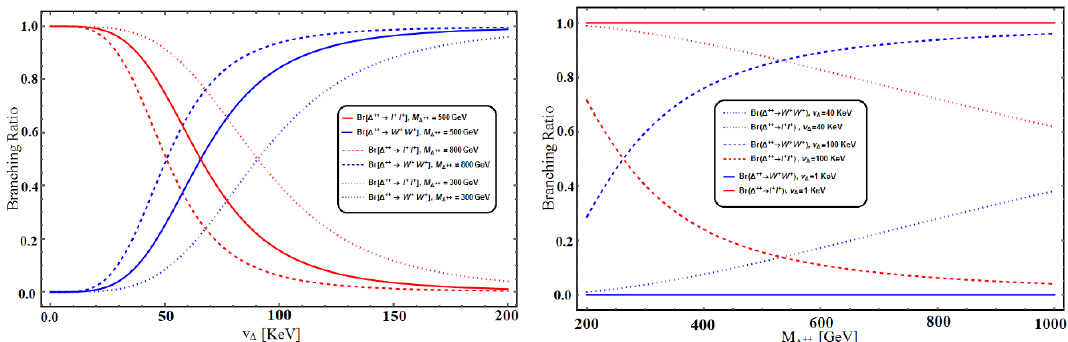
Figure 11 . Left : variation of branching ratio (Br) for di(cid:11)erent decay modes of (cid:1) (cid:6)(cid:6) as a function of vev v (cid:1) for M = 300 (Dotted), 800 (Dashed) and 500 (Solid) GeV. Right : variation of branching ratio (Br) for di(cid:11)erent decay modes of (cid:1) (cid:6)(cid:6) as a function of mass M 100 KeV (dashed) and 1 KeV (Solid). Red and blue lines are for same sign dilepton decay and same sign diboson decay